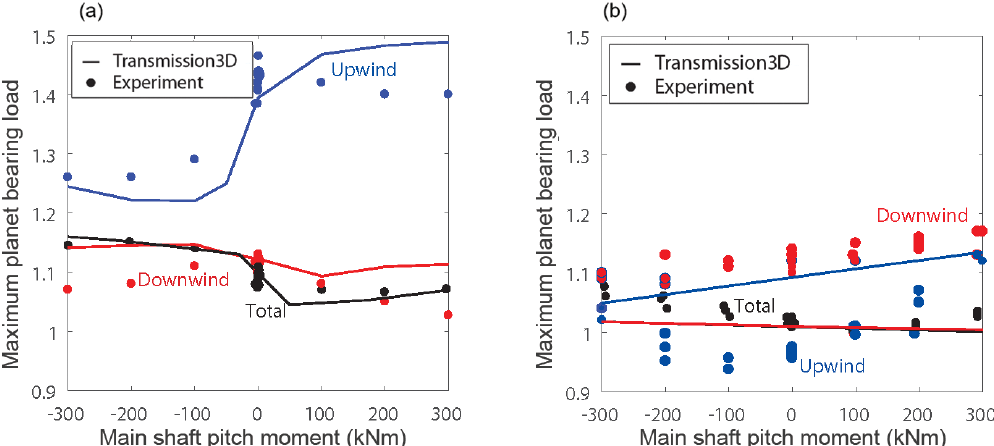
Figure 10. Maximum planet CRB (a) and TRB (b) loads for all pitch moments.